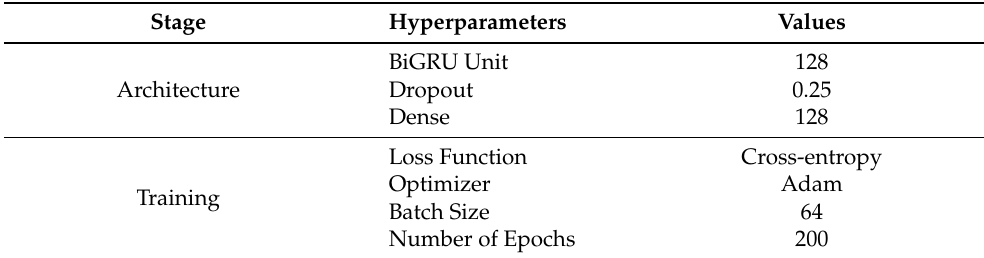
Table A3. The summary of hyperparameters for the BiGRU network used in this